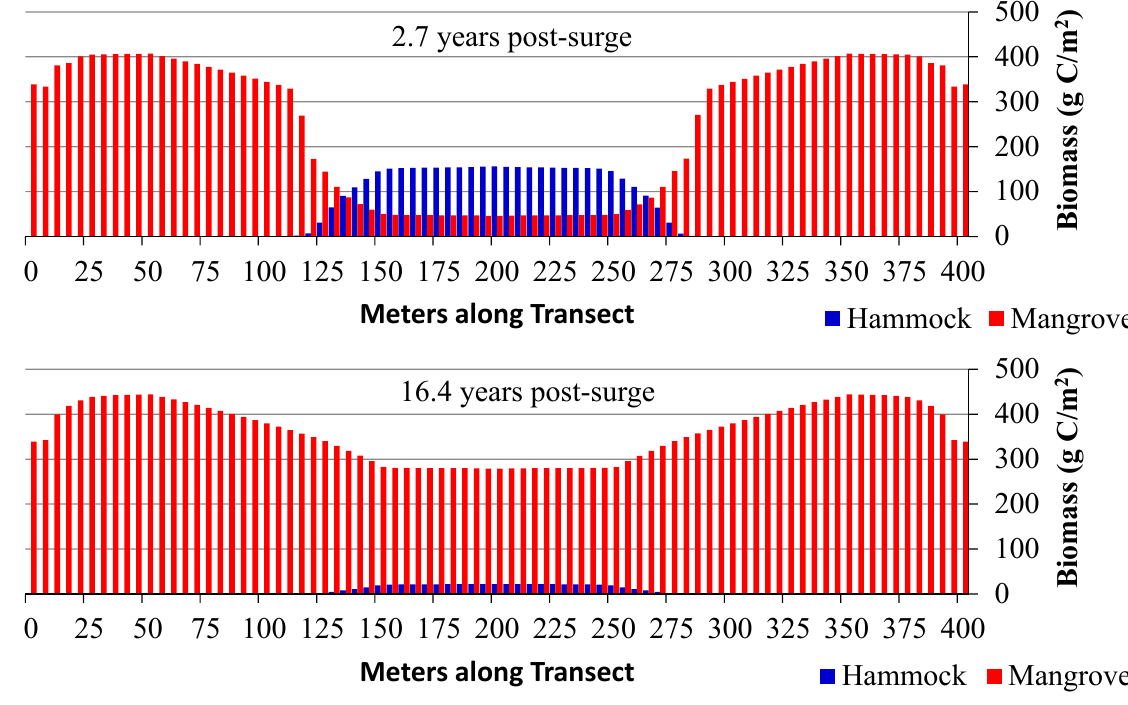
Figure 6. ( Top ) Depiction of precipitation over time used in the scenario, with four-year drought. ( Middle ) Simulated distribution of mangrove (red) and hardwood hammock (blue) vegetation 2.7 years (1000 days) after the storm surge, which occurs at 27.3 years into the simulation. ( Bottom ) Simulated distribution of mangrove (red) vegetation 16.4 years (6000 days) after the storm